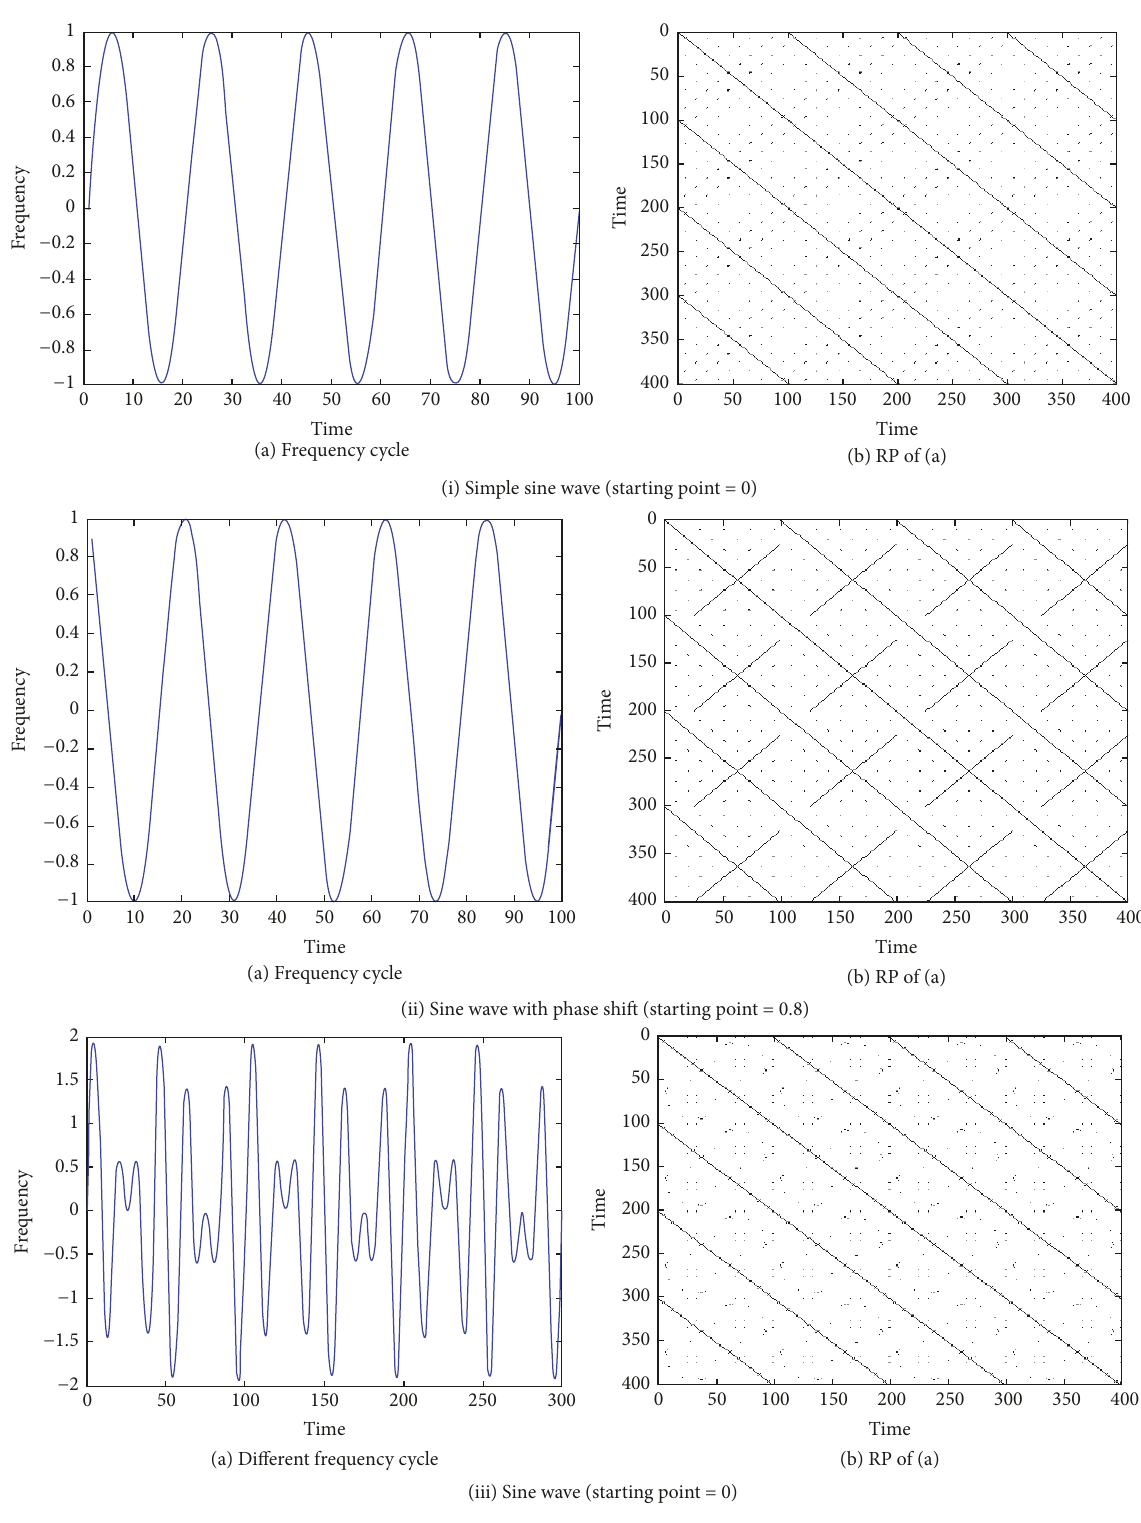
Figure 2: Recurrence plots for sine